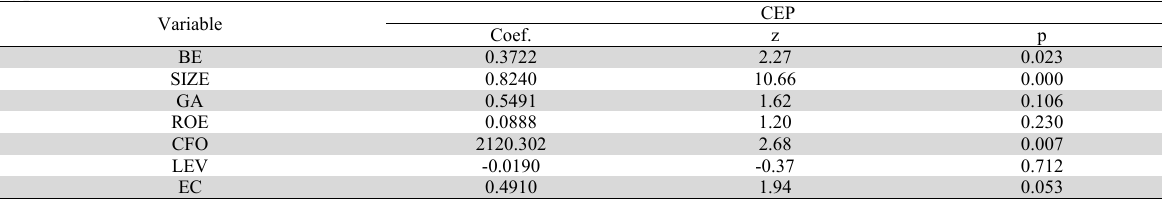
Hyphothesis 3a test result